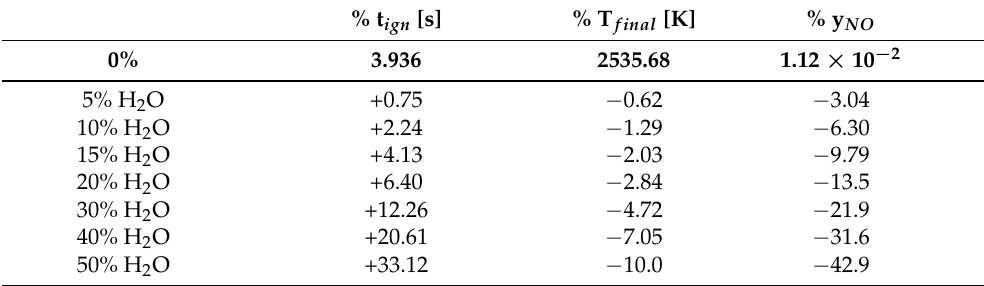
Table 5. Change in ignition delay, final temperature and NO mass fraction with various mole fraction of H 2 O in the initial mixture.